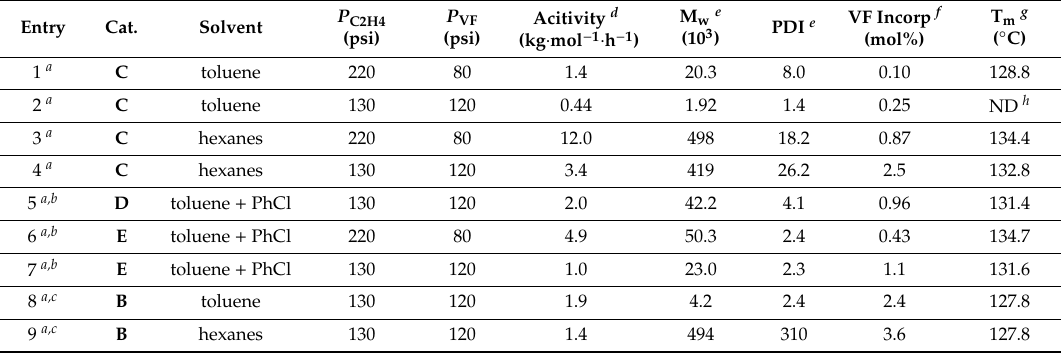
Table 1. Ethylene / vinyl-fluoride copolymerization by catalysts C , D, and E [38].